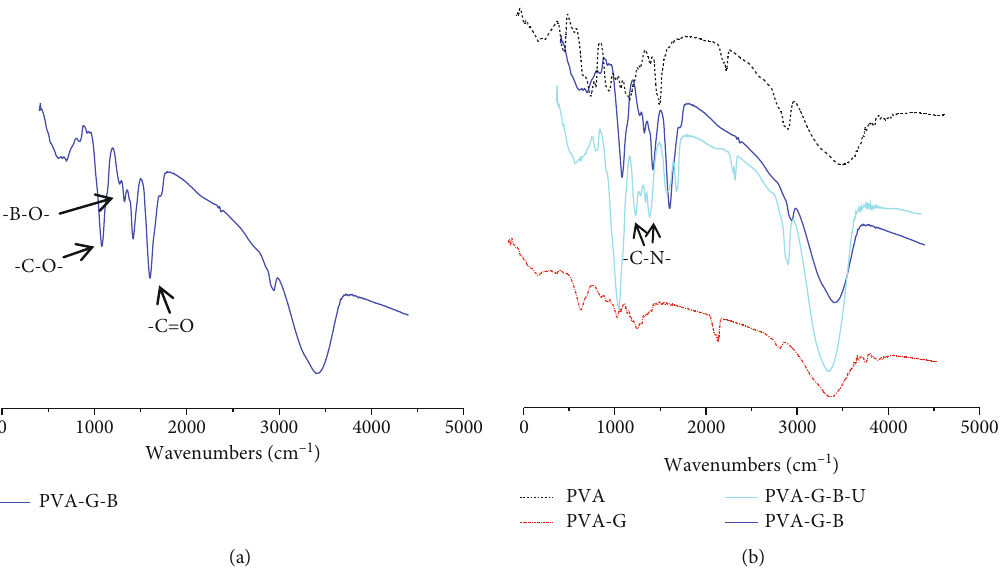
Figure 4: FTIR spectrum of the PVAGB polymer additive (solid blue line). PVA: polyvinyl alcohol; PVAGB-U: PVA modi fi ed by glyoxal, boric acid, and urea [19]; PVA-G: PVA modi fi ed by glyoxal; PVA-G-B: PVA modi fi ed by glyoxal and boric acid (also abbreviated as